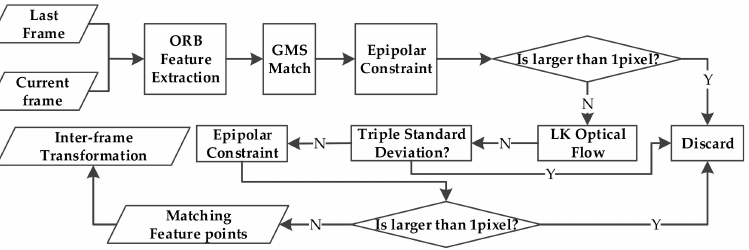
Figure 3. A flow chart of inter-frame transformation based on optical flow and GMS.